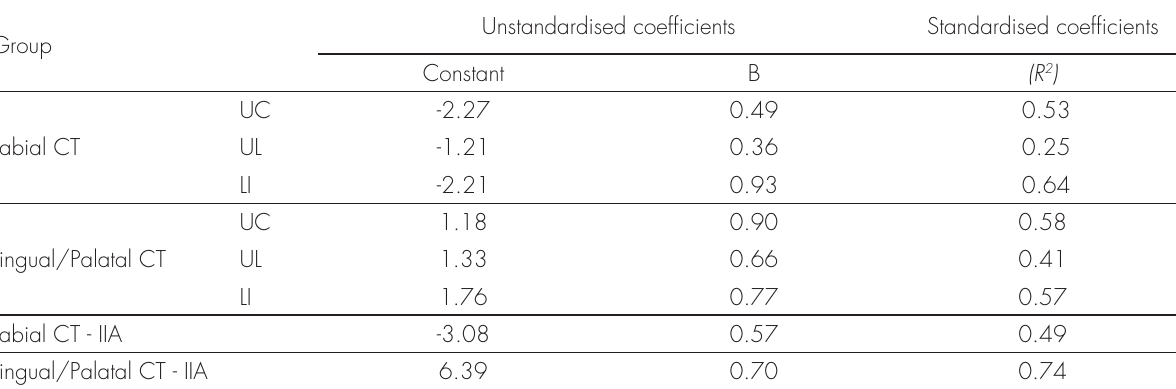
Table IV. Liner regression